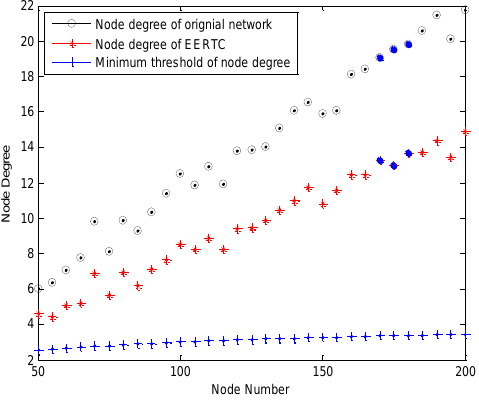
Figure 9. The relationship between node number and node degree.